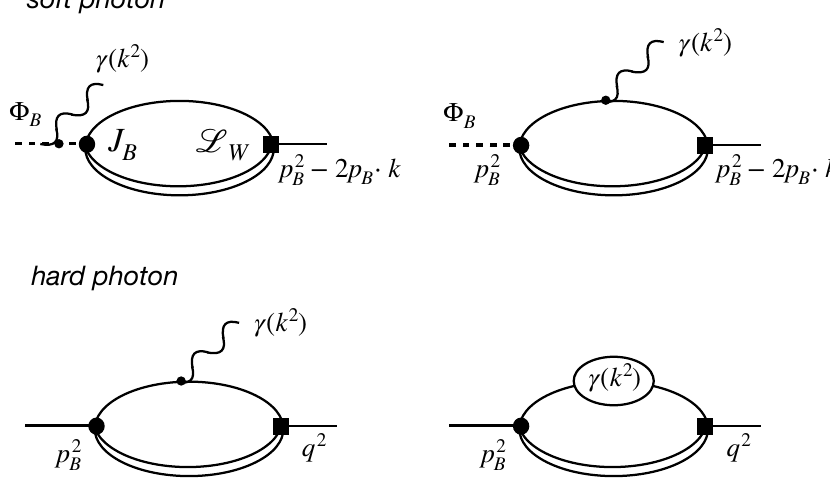
Figure 4 . Comparison of soft and hard photon approaches. In the soft photon approach (top diagrams), q 2 → p 2 − 2 p B · k (since k 2 = 0 ) and p B · k becomes an independent variable. Top B left (right) diagram correspond to the Φ (quarks)-term in (A.5). Note that the top left diagram B reproduces the Low term and the top right diagram is finite as p 0 . In the hard photon B · k → approach (bottom diagrams), q 2 is an independent variable. The Low term is produced by the bottom left diagram (cutting in p 2 ), while the bottom right diagram probes the structure. In B particular, the blob is the photon distribution amplitude (DA) and is generated by a sum over intermediate mesons ρ 0 , ω, φ with quantum numbers of the photon J PC = 1 −− . For an elaborate discussion of this viewpoint, see appendix A of [38]. The mappings of the diagrams between the two approaches are as follows: top left ⊂ bottom left, bottom right ⊂ top right. The first relation follows from the fact that the point-like interaction on the top-left does not “know” anything about the non-perturbative ρ − γ conversion that the photon DA represents and this also implies the second